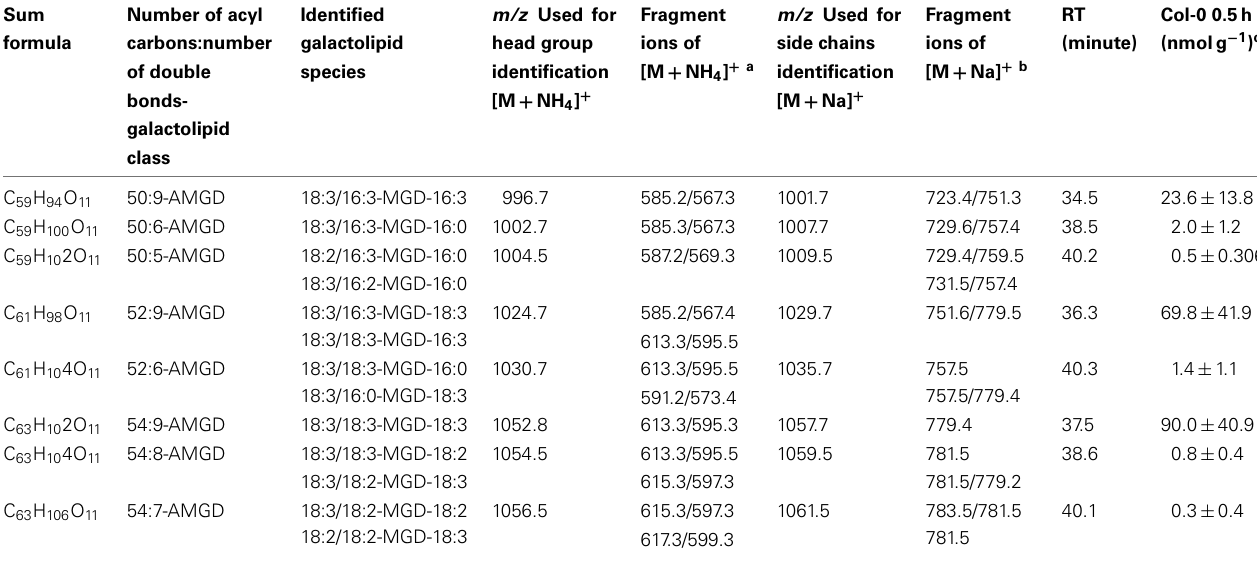
TableA5 | Non-oxidized acylated MGD species identified in wounded A. thaliana leaves. Sum Number of acyl formula carbons:number of